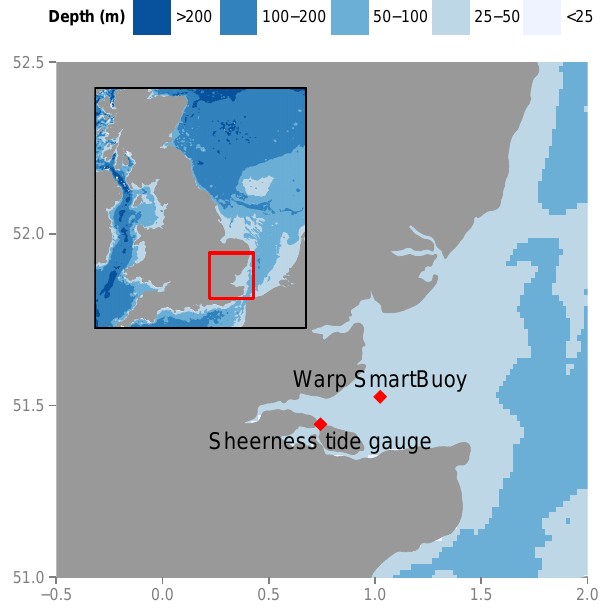
Figure 1. Map of Warp Anchorage study site. Table 1. Study site characteristics for w Winter (November– February) and s Summer (June–September), based on multi-year seasonal means.